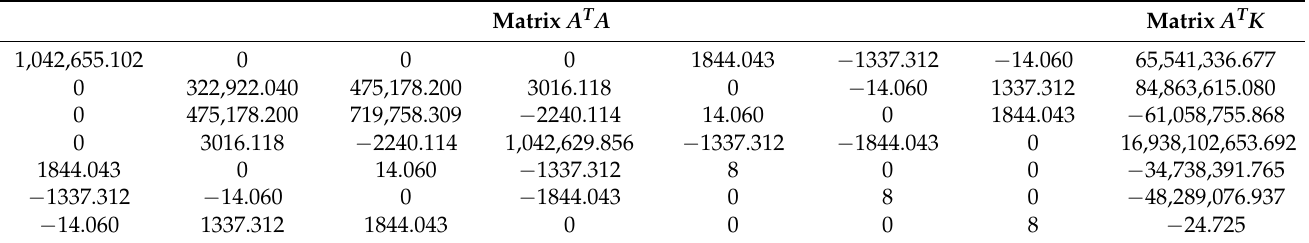
Table 9. Transposed matrices A T A and A T K .